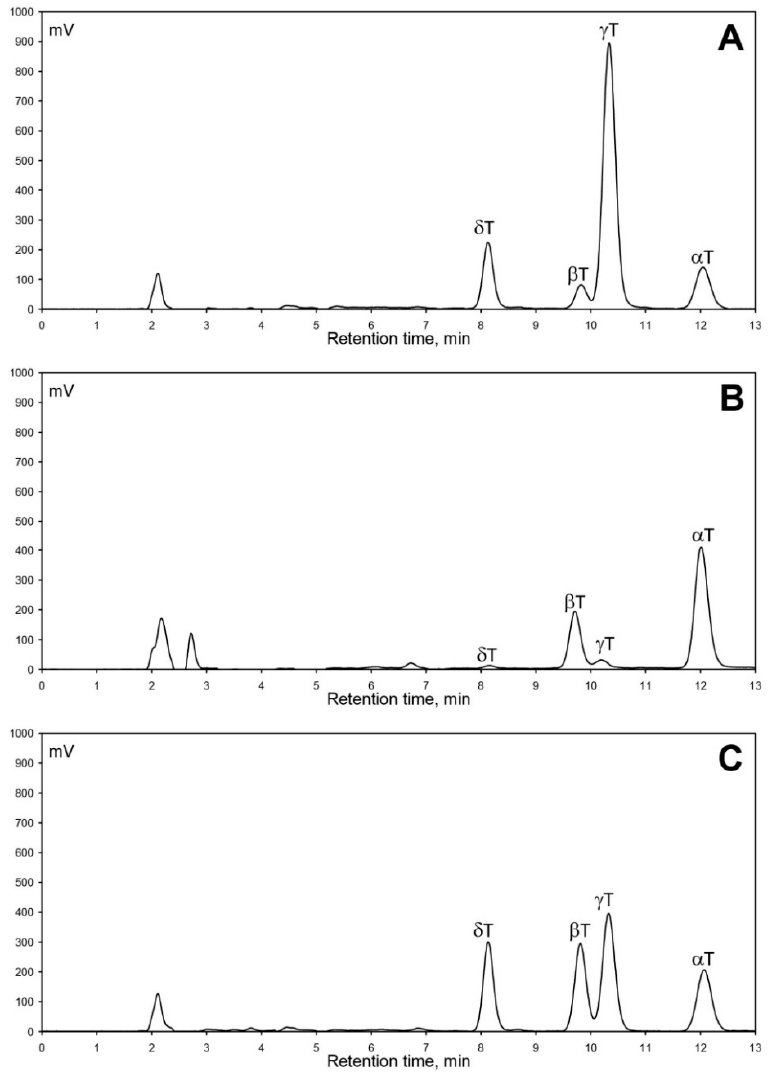
Figure 1. Chromatograms of four tocopherols ( α -T, β -T, γ -T, and δ -T) separated by RP-HPLC/FLD in seeds of three crab apple varieties: ‘Sarkanlapu Krebs’ ( A ); H-17-05-1 ( B ); ‘Pundurkrebs’ ( C ).